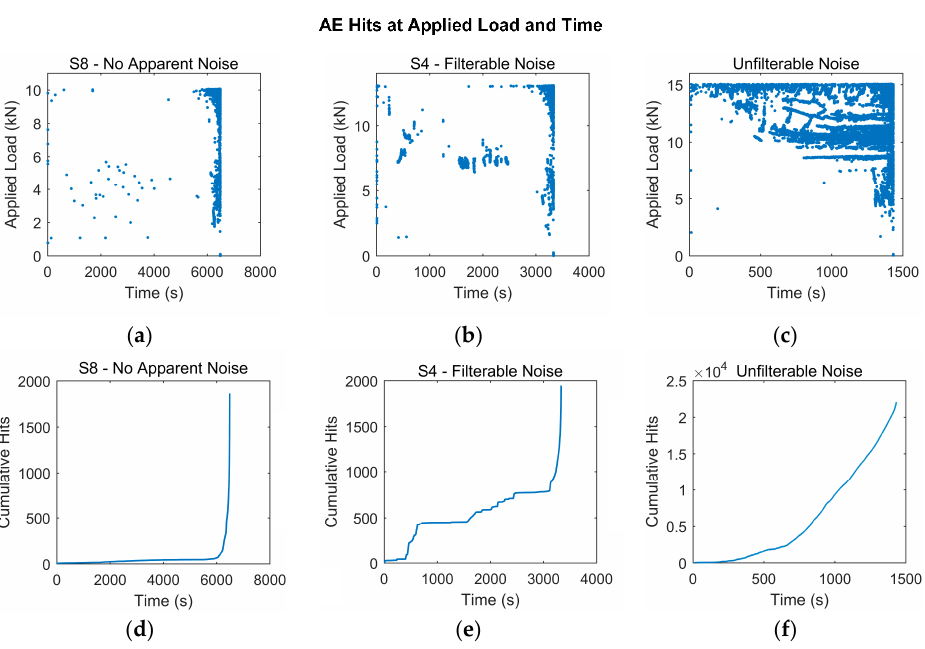
Figure 6. AE signals at their associated loads versus time for three experiments: ( a ) S8 has no apparent AE noise clusters; ( b ) S4 has defined clusters that are assumed to be due to noise and can be filtered; ( c ) another experiment with undefined clusters of noise signals that cannot be filtered with ease; ( d ) cumulative AE hits over time for S8 with no apparent AE noise clusters; ( e ) cumulative AE hits over time for S4 with filterable noise; and ( f ) cumulative AE hits for an experiment with unfilterable